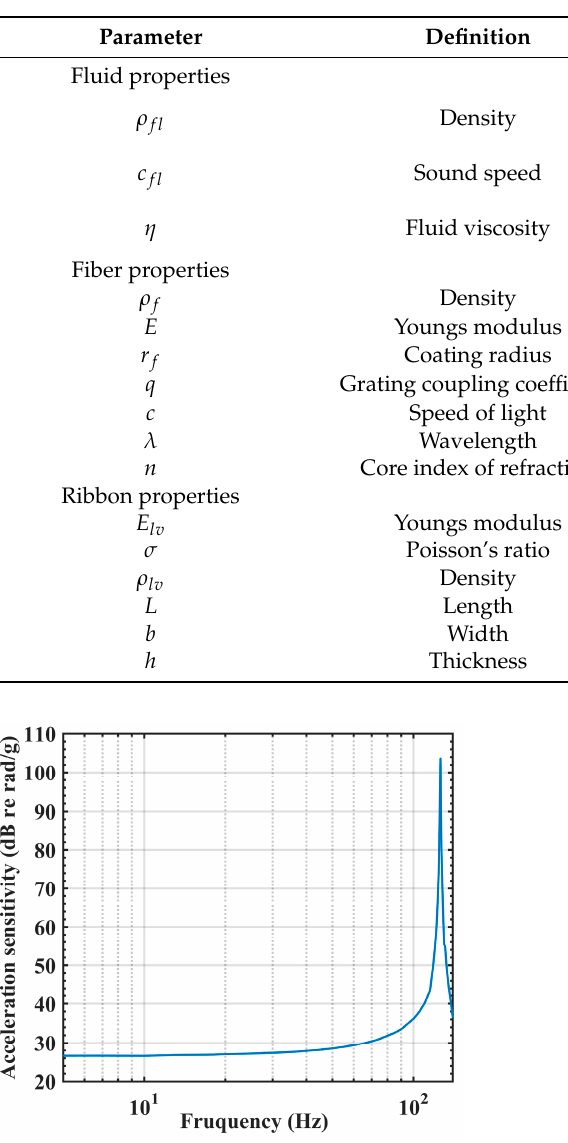
Table 1. Definition of terms.